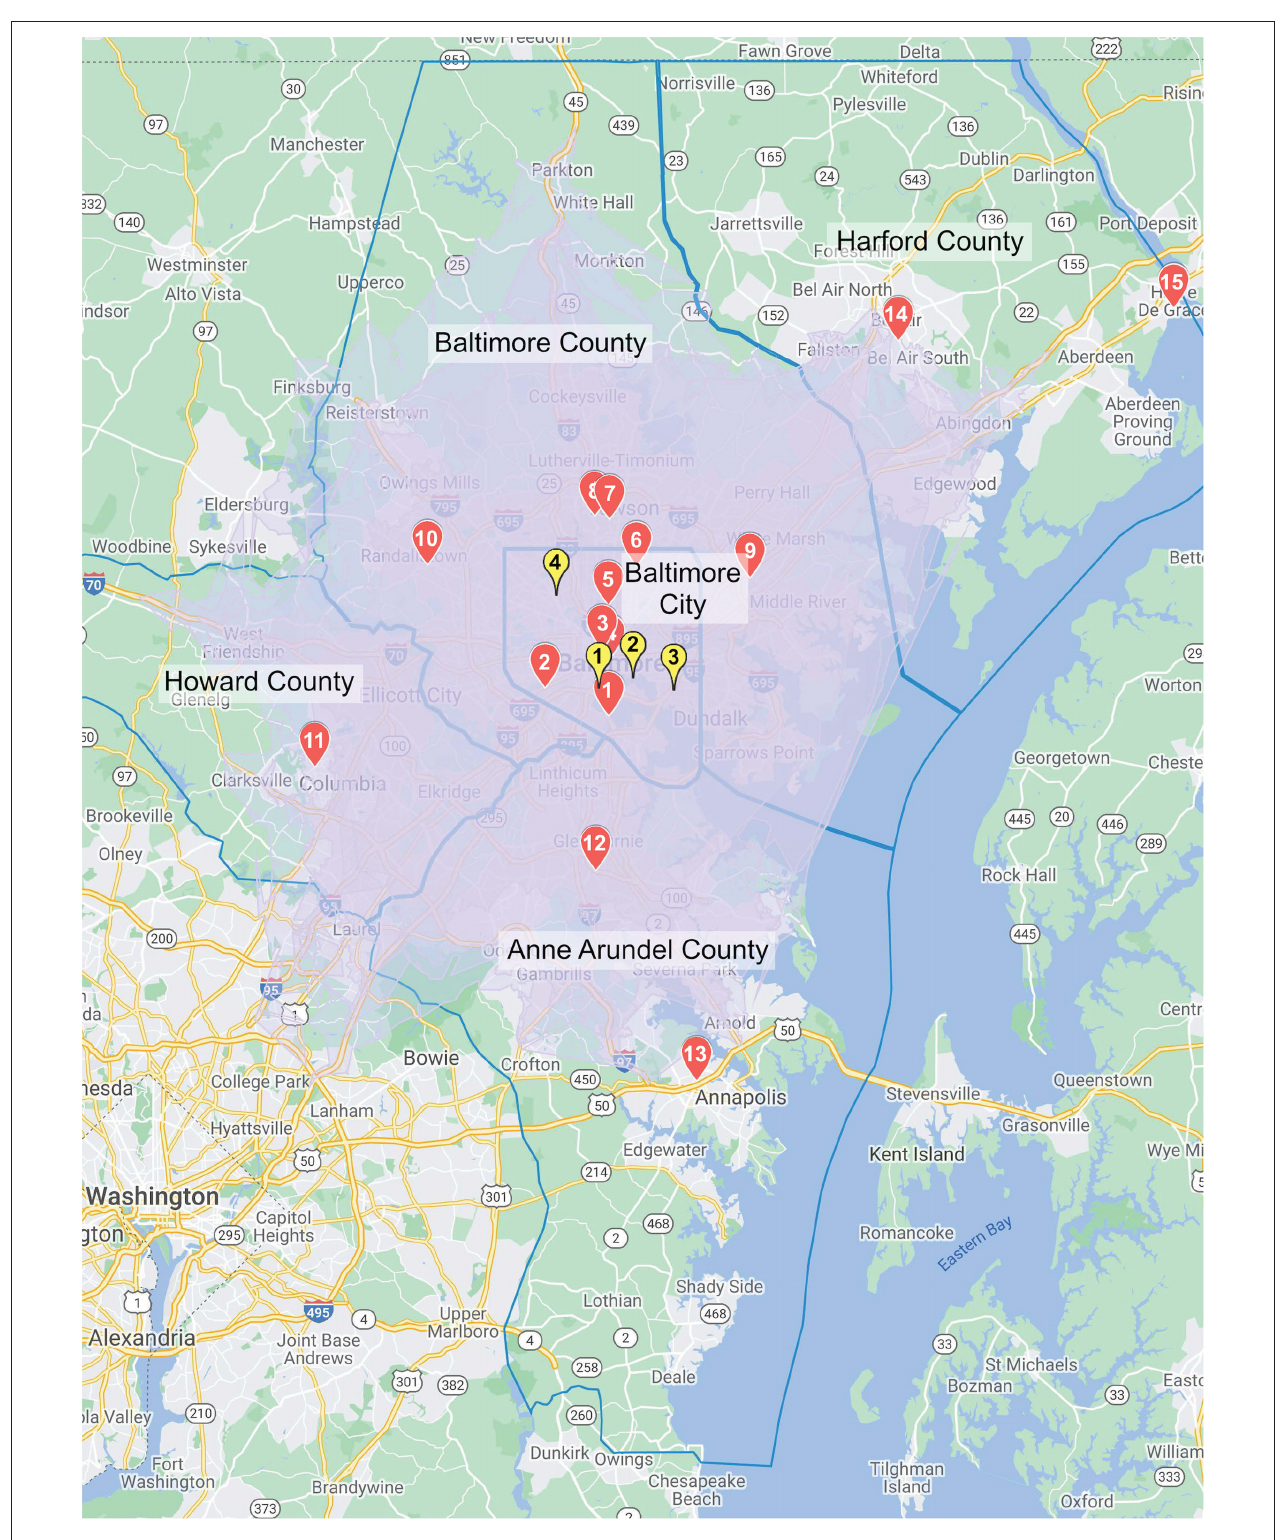
FIGURE 1 | The map depicts the area covered by the re-routing protocol’s 30 min drive-time radius. The red markers represent Primary Stroke Centers and the yellow markers represent Thrombectomy Centers.